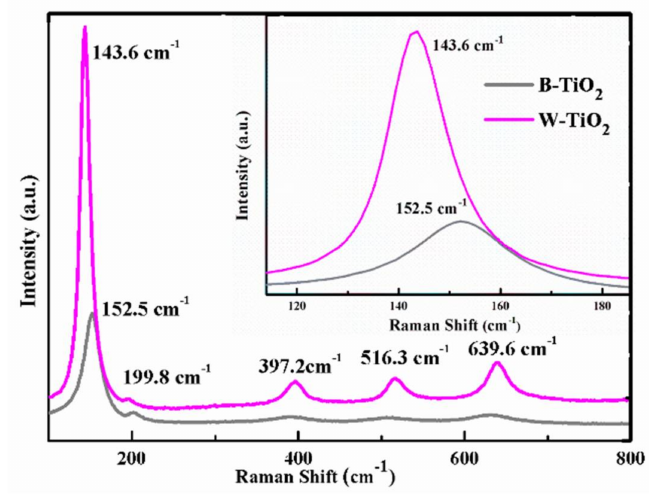
Figure 3. Raman spectra of B-TiO 2 nanoparticles and W-TiO 2 , inset is the magnification of E g